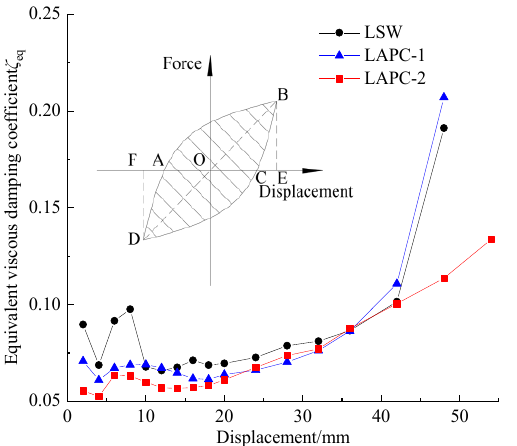
Figure 11. Equivalent viscous damping coefficient displacement curve of specimens.